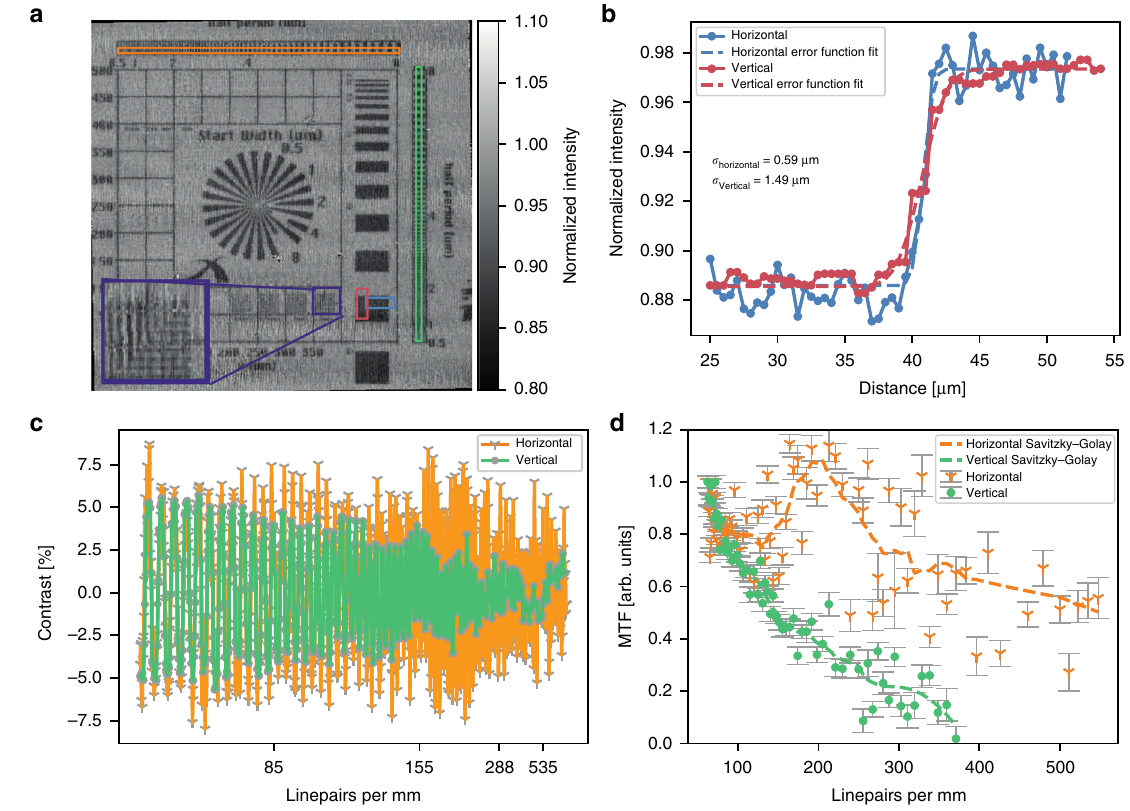
Fig. 4 Analysis of the achieved super resolution. a The reconstructed resolution test chart. The inset is a zoom-in on the lines framed by a purple box in the main image. The vertical lines in the inset are much sharper than the horizontal ones, illustrating the expected resolution gain in the horizontal direction. b – d The results of two quantitative analyses. b The edge-spread function that has been calculated for both directions, the horizontal one in blue and the vertical one in red, exhibits a signi fi cant gain in resolution for the horizontal edge. Displayed is only the region around the edge. c Raw data for the modulation transfer function (MTF) analysis. The horizontal direction is depicted in orange and the vertical one in green. d The resulting MTF values demonstrate a similar performance gain. The dashed lines represent the MTFs after application of a Savitzky – Golay fi lter of third order with a width of 21 data points. The increased MTF around 200 lp mm − 1 is attributed to the fact that this is the spatial frequency of the structured illumination. Error bars indicate the statistical uncertainty. Vibrations of the monochromator cause artifacts in the image that translate into fl uctuations of the MTF that cannot be quanti fi ed. The regions of interests for both analyses are indicated as boxes of the corresponding colour in